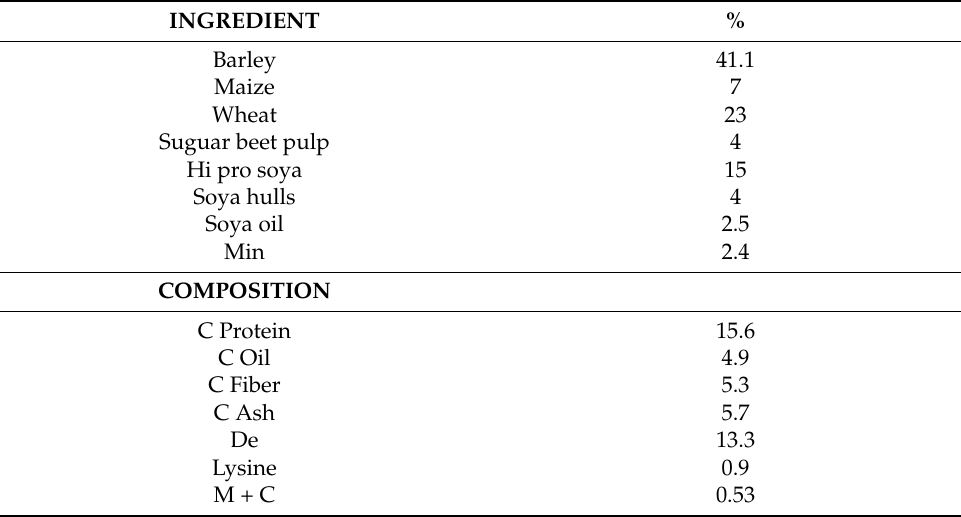
Table 1. Ingredients and composition of the gestation